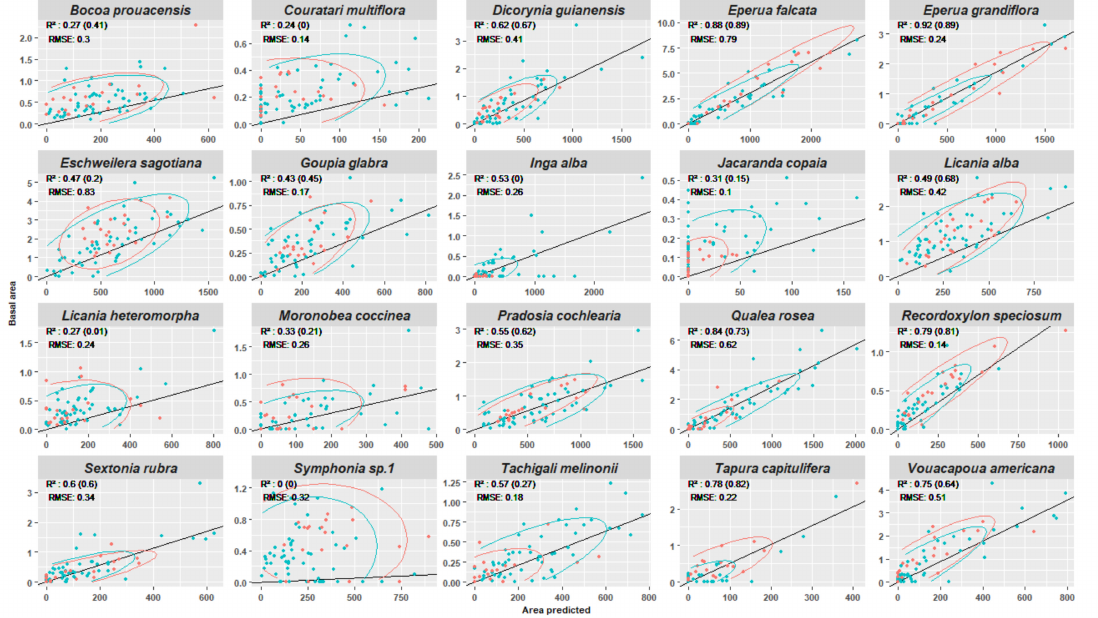
Figure A3. Relation between basal areal (m 2 · ha − 1 ) and area predicted (m 2 · ha − 1 ) using the optimized LDA. Plots not used for training are plotted in red and the R-squared for those observations are given in brackets. The plots used for the training are in blue. Global R-squares are given using all data points (red and blue). In solid black line, linear regression based on all points passing through zero. The normal confidence ellipses are given, computed for each group of points using the corresponding color (red or